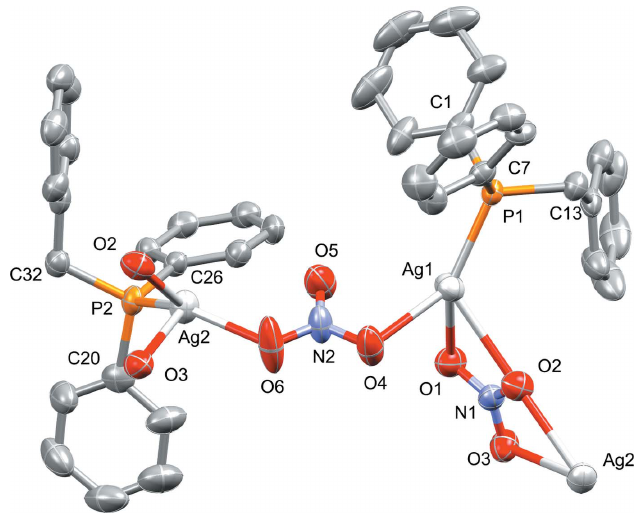
Figure 1 The molecular structure of the asymmetric unit in the title compound showing displacement ellipsoids at the 50% probability level. Hydrogen atoms are omitted for